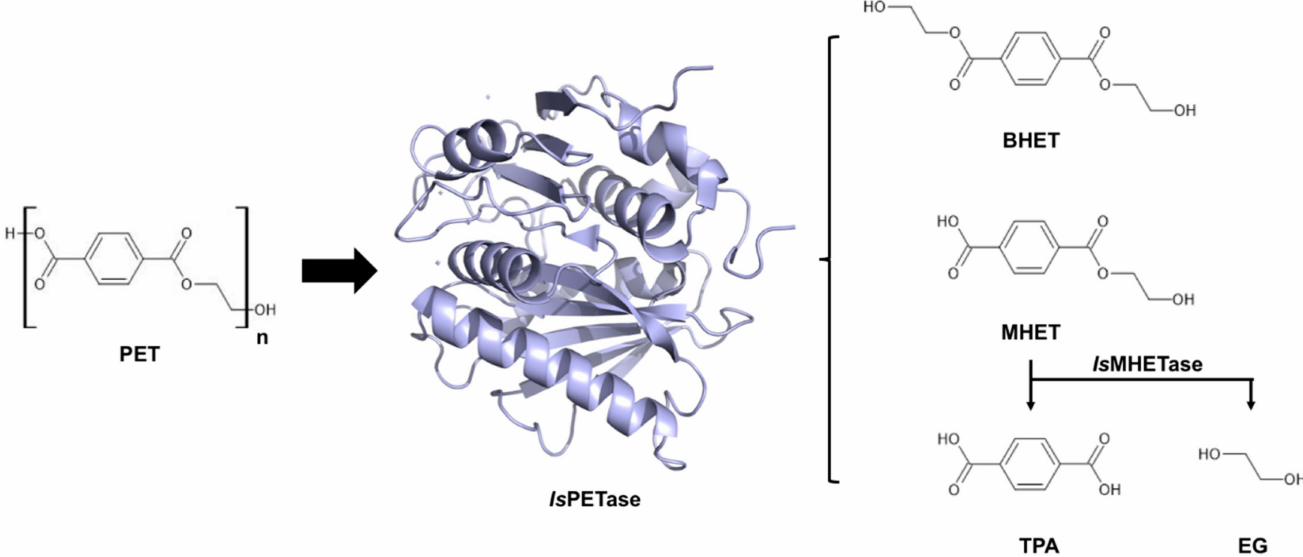
Figure 1. Chemical structure of Is PETase substrate and products. PET: polyethylene terephthalate, BHET: bis(2-hydroxyethyl) terephthalic acid, MHET: mono(2-hydroxyethyl) terephthalic acid, TPA: terephthalic acid, EG: ethylene